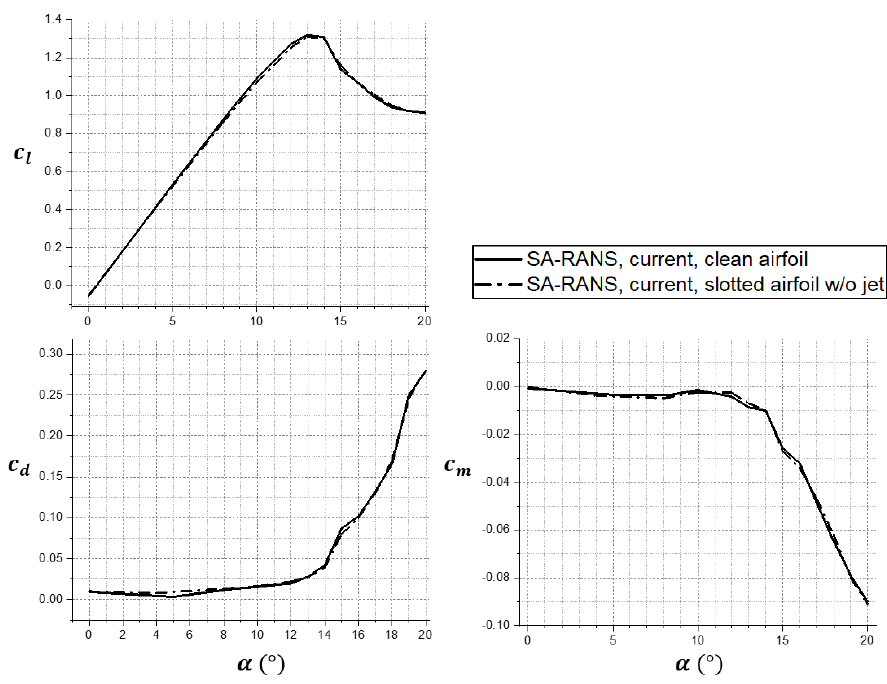
Figure 6. Comparison between the clean and the tangentially slotted